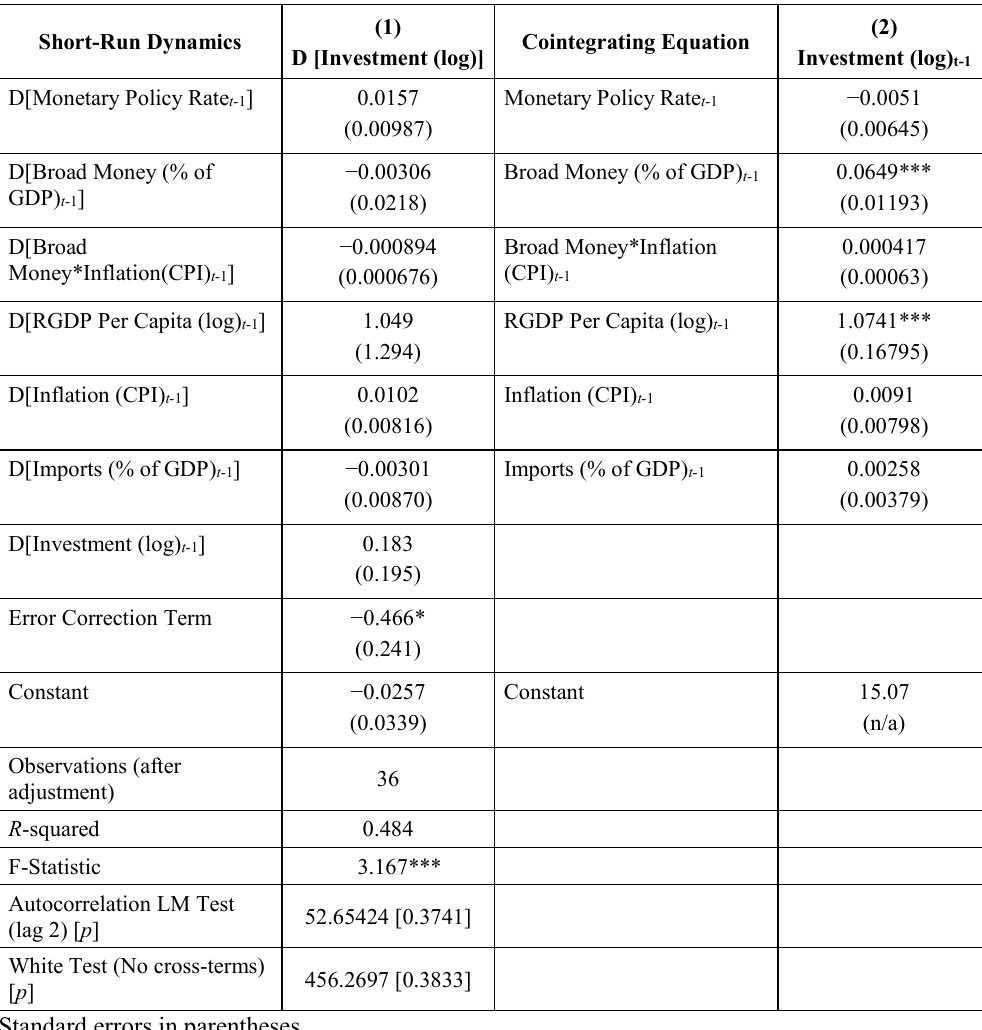
Table 8. Regression Result (with Interaction